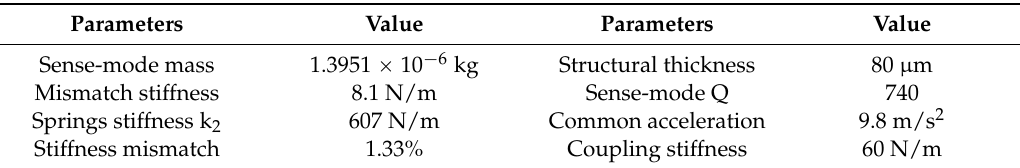
Table 1. Parameters used in the theoretical model.